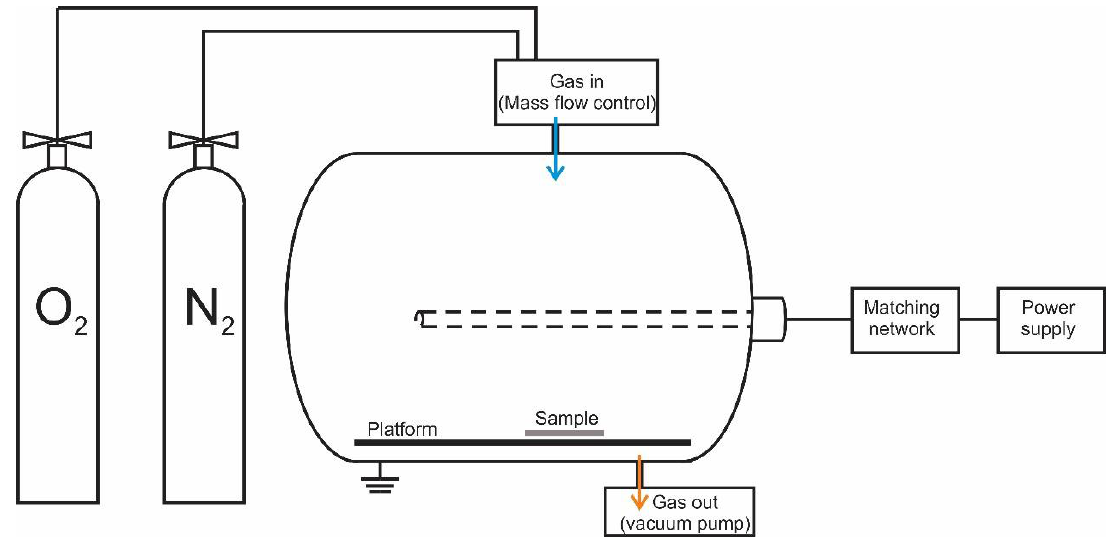
Figure 1. Asymmetrical CCP system used for treatments of cotton samples. The power of the RF power supply was 100 W, the working gases were O 2 and N 2 , the pressure 200 mTorr and the treatment time 5 min. The platform positioned at the bottom of the chamber is grounded.